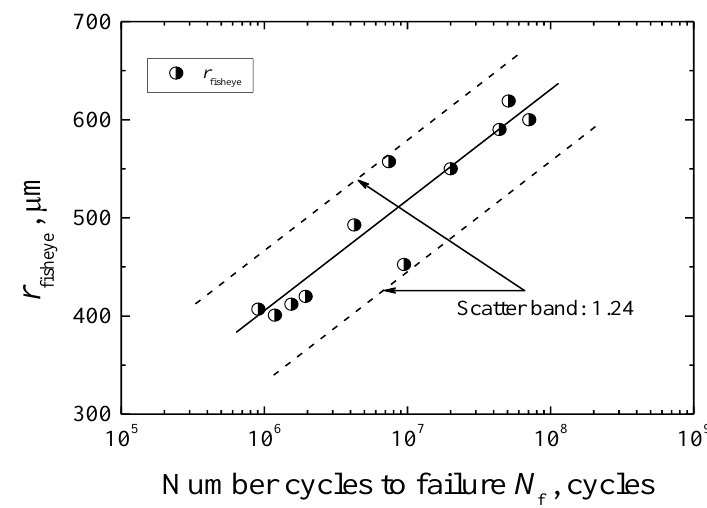
Figure 9. Relationships between radius of fisheye ( r fisheye ) and N f .